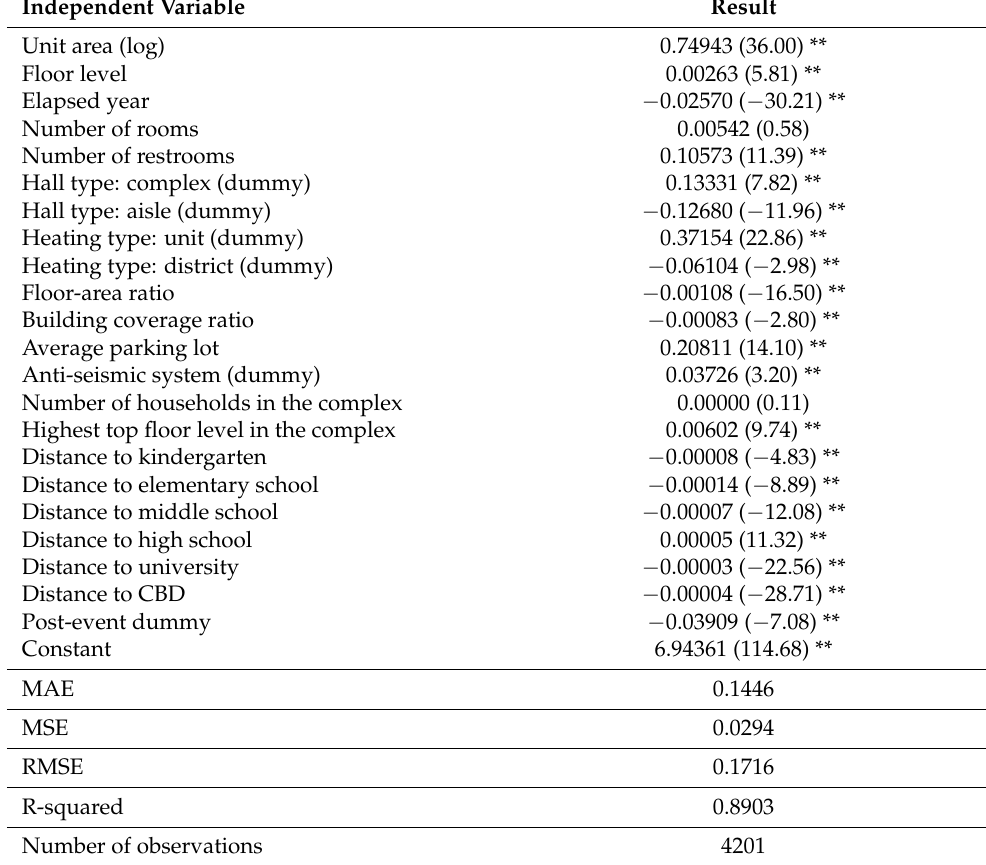
Table 4. Regression